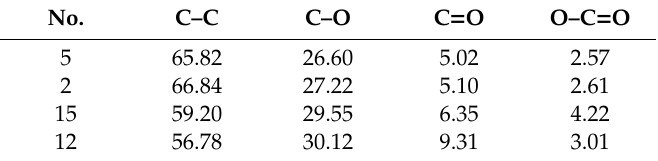
Figure 5. The XPS spectrum of the representative recycled carbon fibers. (( a ) No. 5; ( b ) No. 2; ( c ) No. 15; and ( d ) No. 12.). Table 7. Contents of surface functional groups of different reaction conditions (Unit: %).